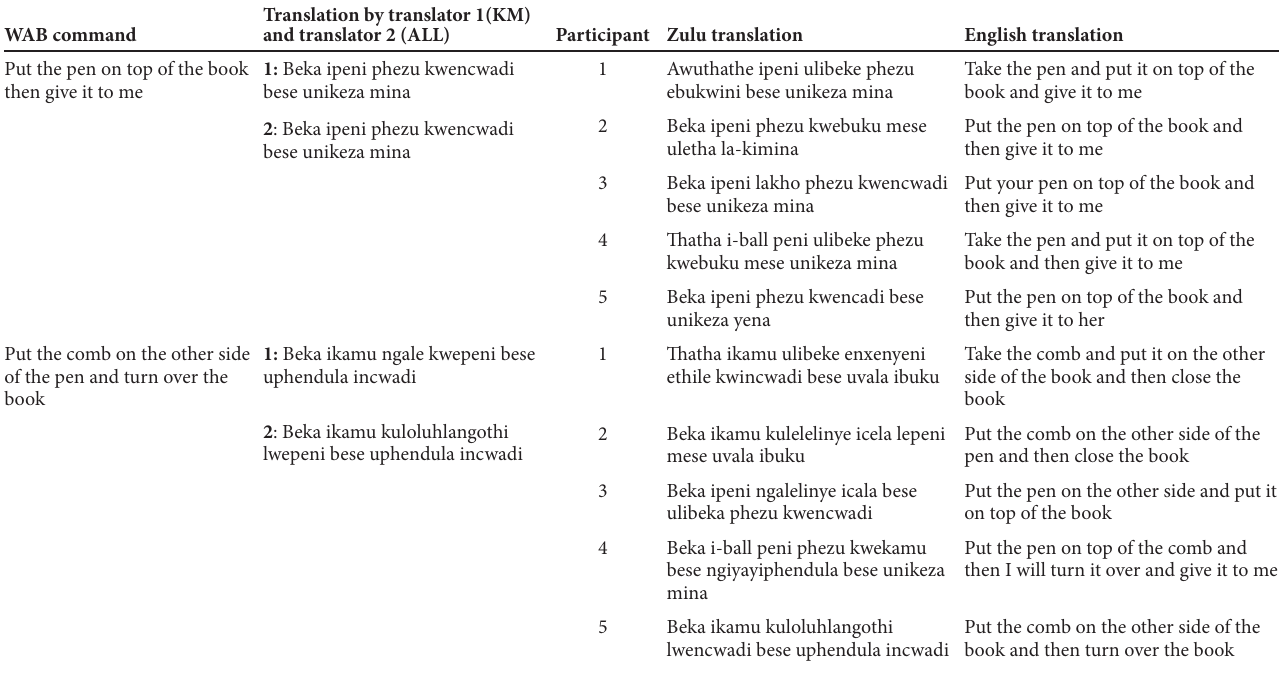
Table 4. Translation of the sequential commands subtest of the WAB (continued) WAB